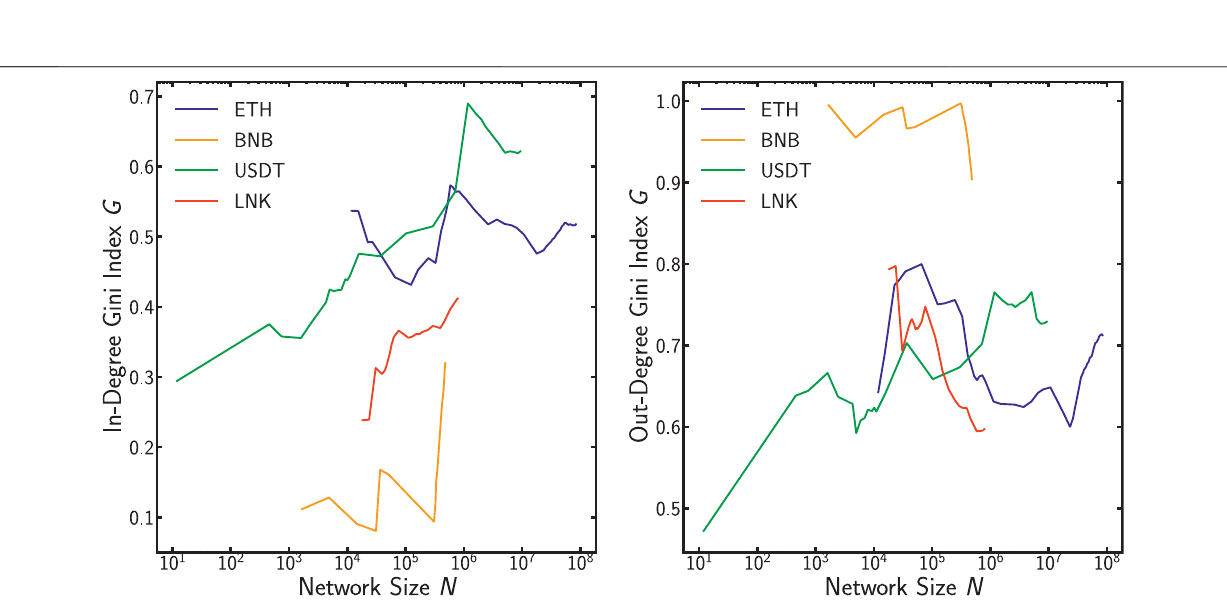
Frontiers in Physics |